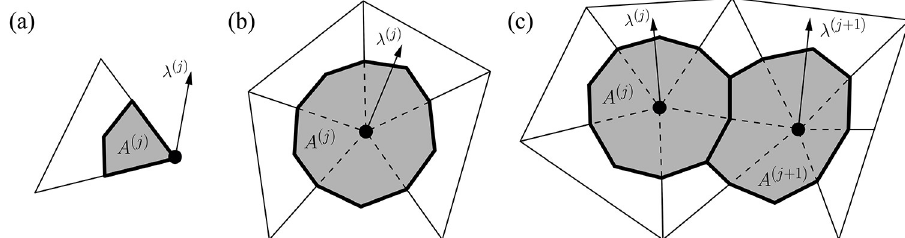
Fig 6. Various cases of pressure calculations. (a) One element case. (b) Five elements case. (c) Two nodes